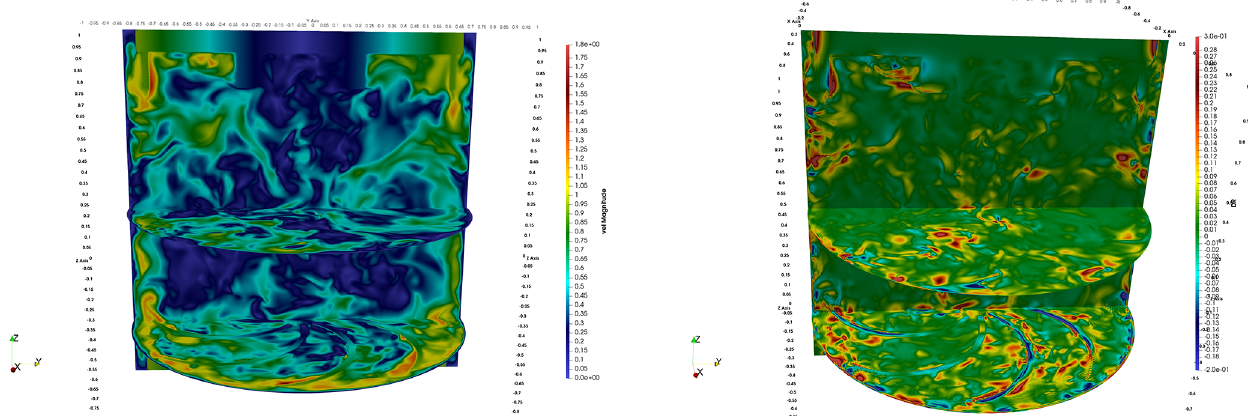
Figure 12. (a) Instantaneous magnitude of velocity fluctuations. (b) Local energy transfers in the von Kármán flow (pictures courtesy of Hugues